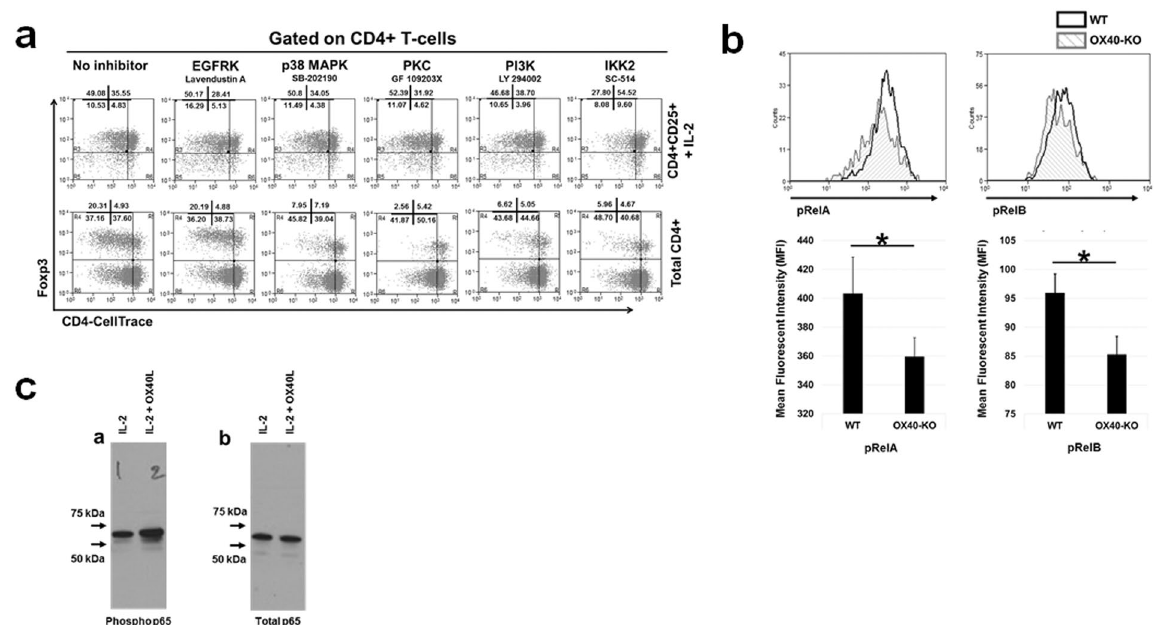
Figure 3. Signalling pathways involved in Treg proliferation induced by G-BMDCs. ( a ) Total CD4 + and CD4 + CD25 + T-cells isolated from NOD mice spleen were CellTrace violet-labelled, incubated for 6 hrs in the presence of various kinase inhibitors, and then co-cultured with WT-BMDCs in the absence (total CD4 + T cells) or presence (CD4 + CD25 + T-cells) of exogenous IL-2 (5 U/ml). Cells were harvested on day 5 and analysed by flow cytometry for Treg proliferation. Representative dot plots for Treg proliferation are shown for indicated inhibitors. ( b ) WT and OX40-KO splenic CD4 + T-cells were isolated, labelled with CellTrace violet and co- cultured with MHC-class II-KO-BMDCs in presence of exogenous IL-2 (1 U/ml). After 5 days, cells were harvested and analysed by flow cytometry for activation of NF-kB pathway. Mean fluorescence intensity (MFI) of the indicated molecules are shown in bar graphs. ( c ) CD4 + T-cells isolated from splenocytes were treated with IL-2 alone or with IL-2 and OX40L for 24 h. Cells were lysed and analysed for NF-kB-p65 phosphorylation using total and phospho-p65 antibodies by western blot. Values show average ± SD, * P < 0.05, ** p < 0.005, and *** p <